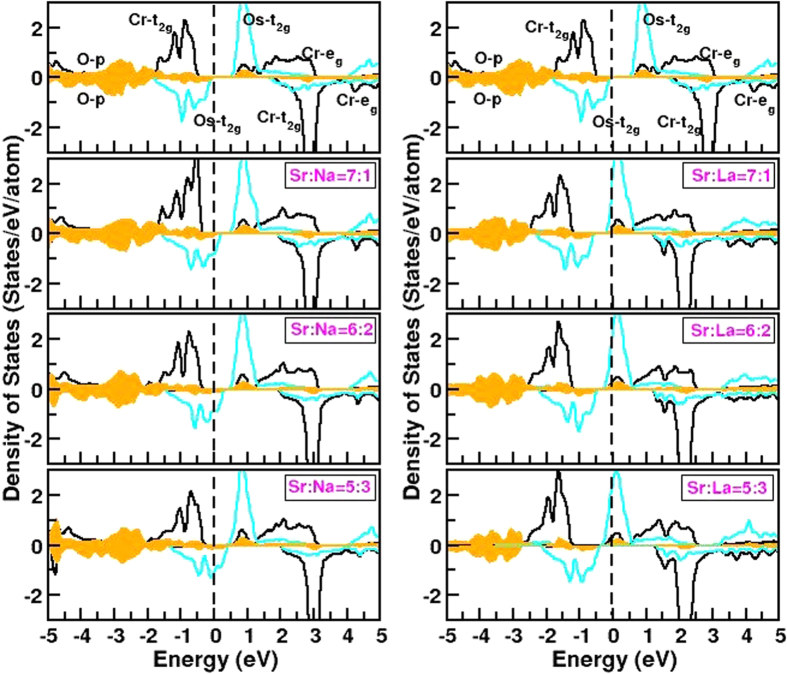
Left panel: GGA + U + SOC density of states of the parent compound, and the Na doped compounds.From top to bottom, the various panels refer to parent compound, Sr1.875Na0.125CrOsO6, Sr1.75Na0.25CrOsO6, Sr1.625Na0.375CrOsO6 compounds respectively. The zero of the energy marks the position of EF. The black, cyan, yellow shaded area represent the states projected to Cr d, Os d and O p states, respectively. Right panel: Same as left panel, but shown for parent and La doped compounds. From top to bottom, the various panels refer to parent compound, Sr1.875La0.125CrOsO6, Sr1.75La0.25CrOsO6, Sr1.625La0.375CrOsO6 compounds respectively. The dashed, vertical lines in each panel mark the positions of Fermi level.